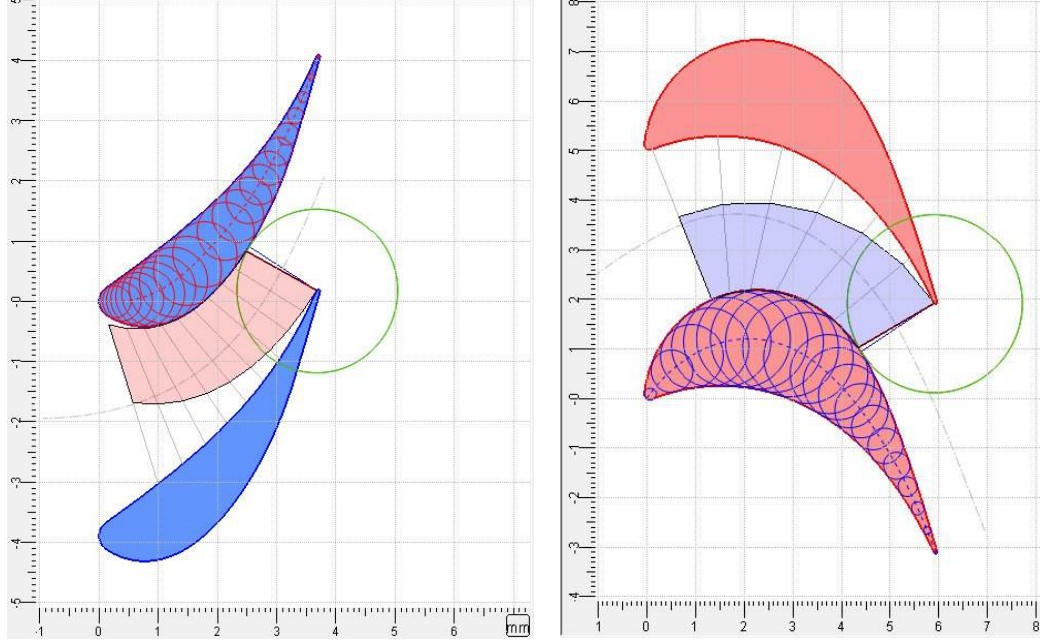
Figure 28. Stator (blue) and rotor (red) optimized